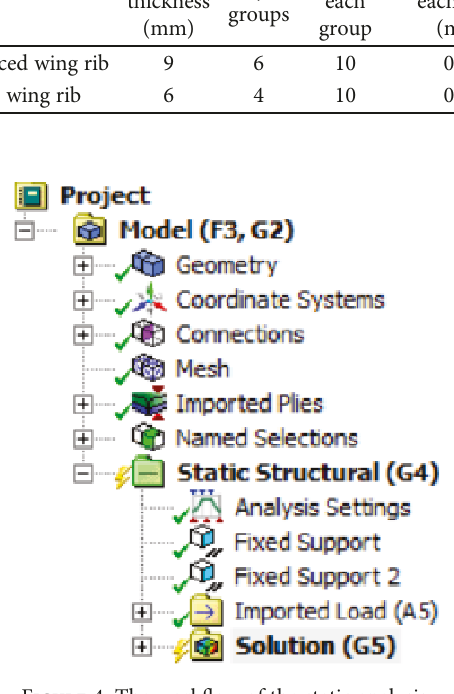
Figure 4: The work fl ow of the static analysis.